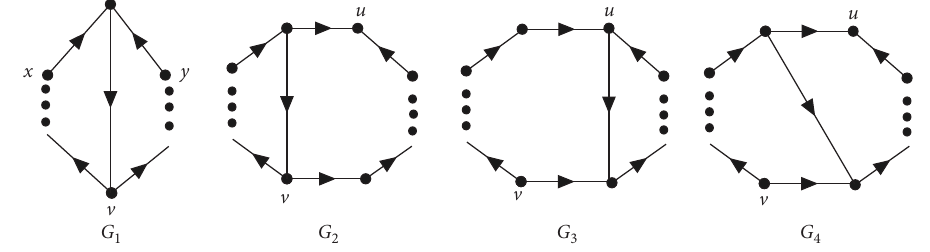
Figure 1: Singular